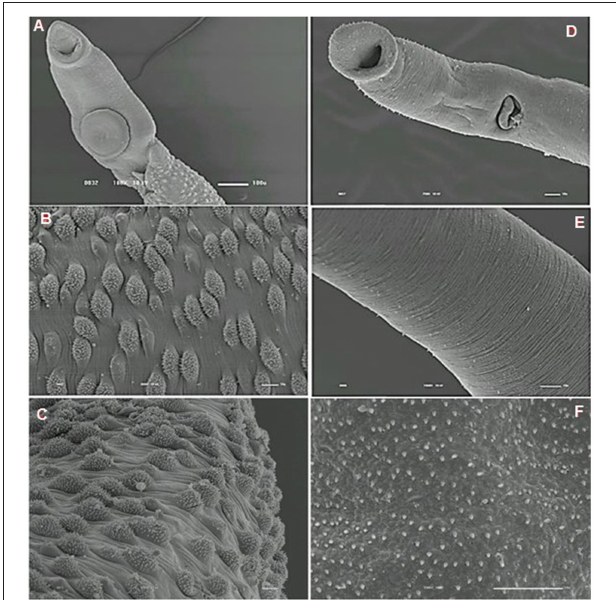
FIGURE 6 | Scanning electron microscopy of S. mansoni PZQ-susceptible strain. (A–C) Susceptible strain adult males of control group kept in RPMI-1640 drug free medium for 3 h, showing normal morphology of the tegument, and oral and ventral suckers; (D–F) Susceptible strain adult females of control group kept in RPMI-1640 drug free medium for 3 h, showing normal morphology of the tegument, and oral and ventral suckers. Image marginations: (A) 180x 10 kV ________100u; (B) 900x 10 kV ________10u; (C) 800x 10 kV ________10u; (D) 500x 10 kV ________10u; (E) 1200x 10 kV ________10u; (F) 3300x 10 kV ________10u.